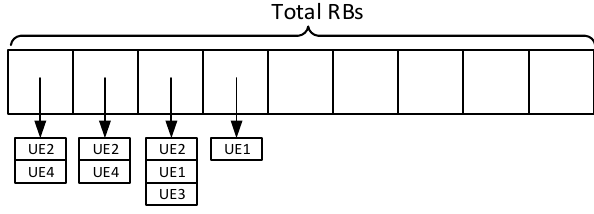
Figure 13. Allocation map with frequency reuse.